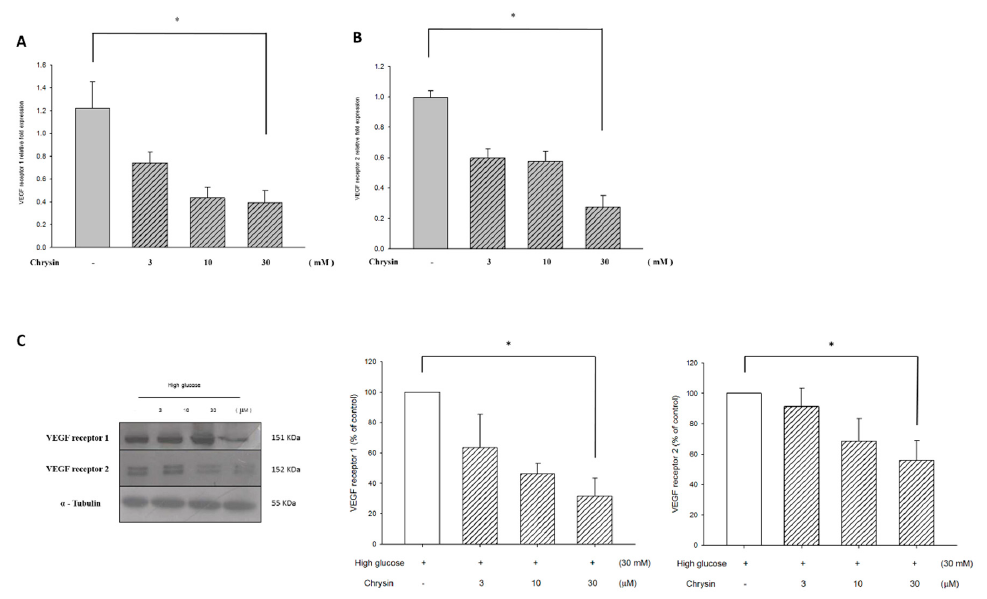
Figure 7. Chrysin decreased the mRNA levels of VEGF receptor1 ( A ) and VEGF receptor2. ( B ) RF / 6A cells were treated with chrysin and then harvested after charging high glucose (30 mM) for 16 h, and qRT-PCR was performed for the mRNA expression levels. Results are expressed as a percentage of control and mean ± SE. * p < 0.05 vs control. ( C ) Chrysin reduced the protein expression levels of VEGF receptors. RF/6A cells were treated with chrysin and then harvested after changing high glucose for 16 h. A western blotting was performed for the protein expression levels with the quantification data shown on the right panel. All data was acquired by means of ± SE from at least three independent experiments.